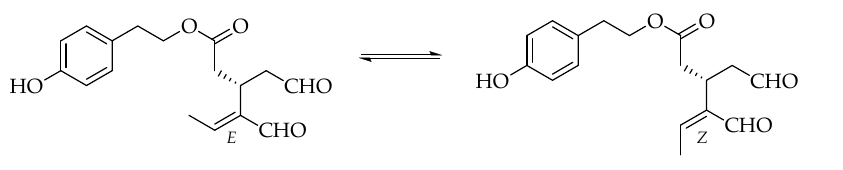
Figure 10. Oleocanthal interconversion.